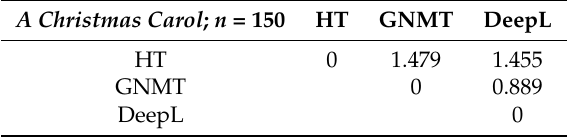
Table 7. Delta scores of each translation of A Christmas Carol ( n =